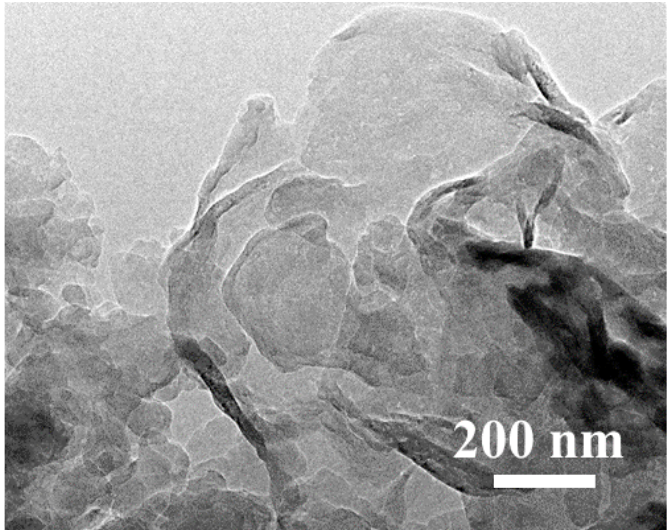
Figure 6. TEM image of CN-700.